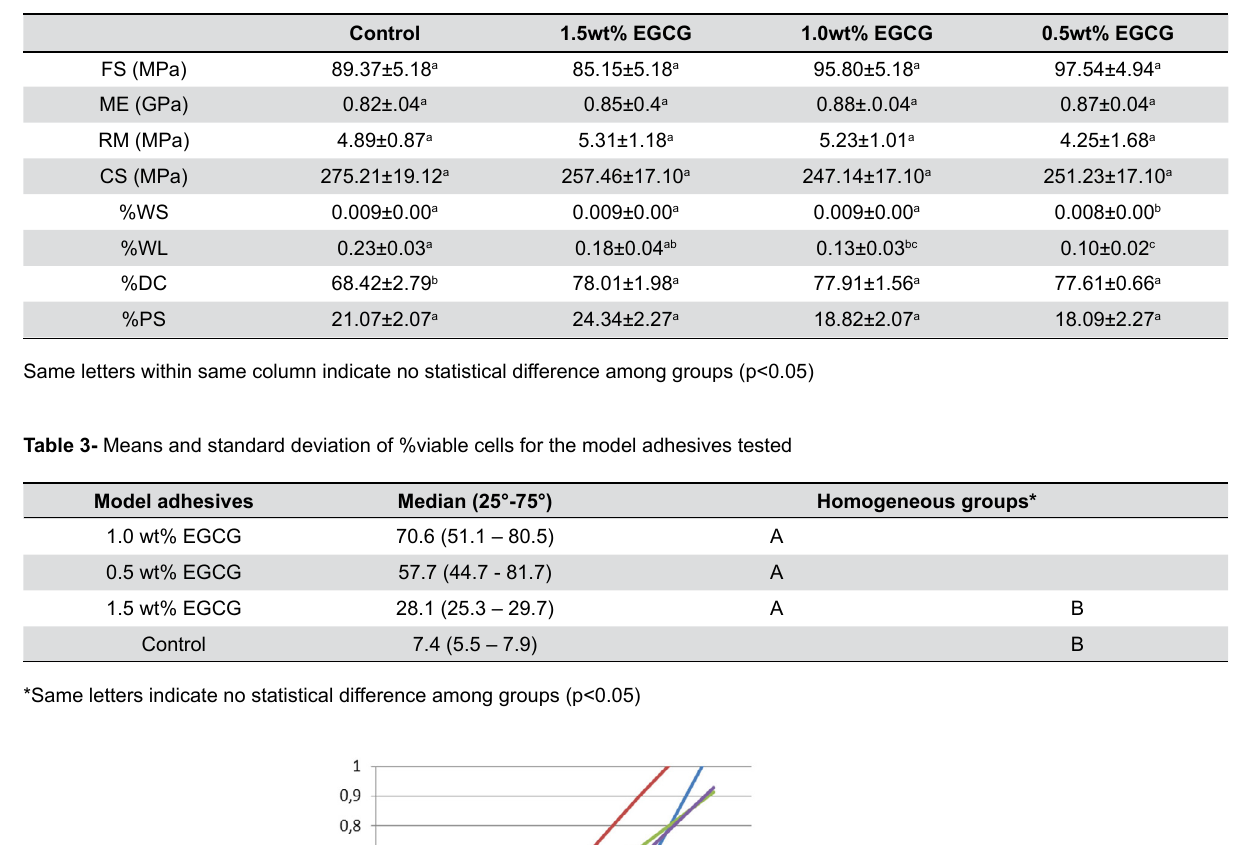
Table 2- Mean values ± standard deviation of flexural strength (FS), modulus of elasticity, (ME), modulus of resilience (RM), compressive strength (CS), water sorption (%WS), water solubility (%WL), degree of conversion (%DC) and polymerization shrinkage (%PS) values of model adhesives